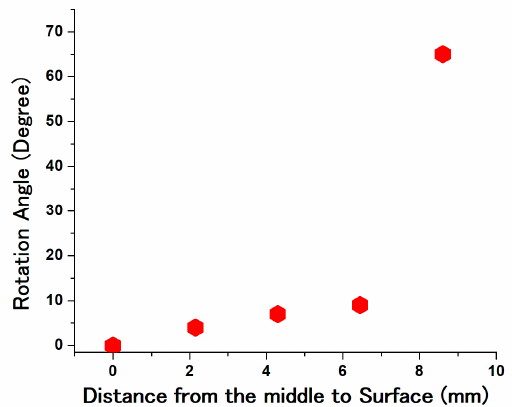
Figure 11. pole rotation of (0002) pole figure of Mg.